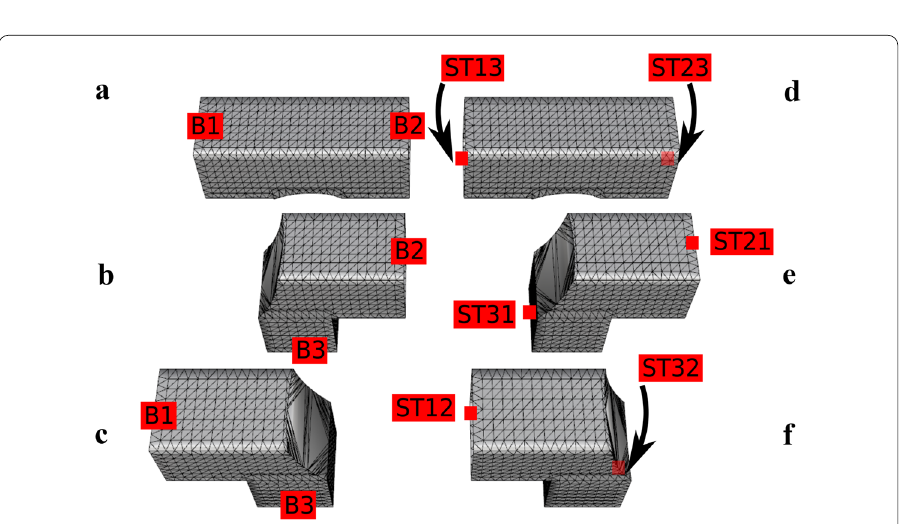
Fig. 7 Boundary seed points computation. Temporary patches P T 3 , P T 1 and P T 2 respectively in ( a – c ). Using an approach close to circular conformal mapping, temporary seed points s Tk are determined into